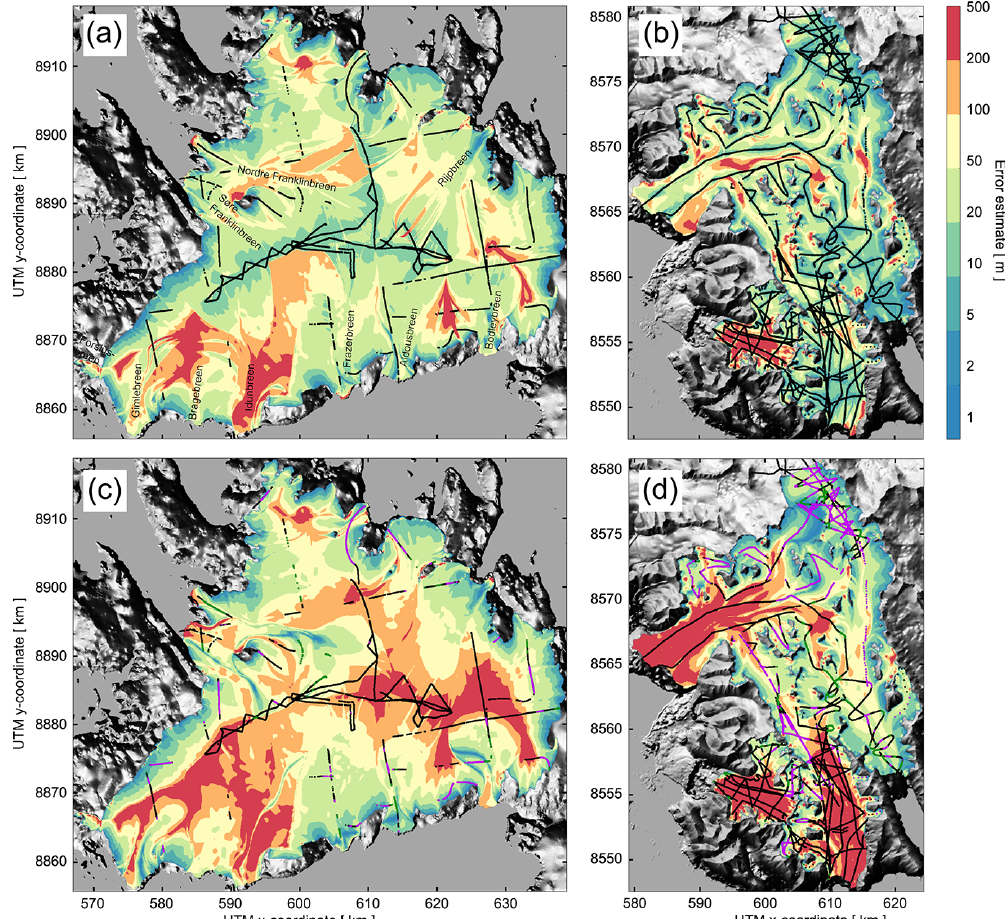
Figure 6. Error-estimate map based on the error propagation presented in Sect. (2.2.5) for VIC (a, c) , THPB and WSB (b, d) . Values are most elevated in the vicinity of unconstrained ice divides and ridges as well as in other stagnant areas. Error estimates are equal to the measurement uncertainty where observations were collected. Upper and lower panels reflect the amount of considered thickness measurements as in Fig. 4. Black dots indicate the measurement locations. For the withheld fraction of measurements, dots are coloured where the difference between observed and reconstructed thickness values exceeds the error bounds. For these outliers, green or purple colours indicate that observations are strongly over- or underestimated by the reconstruction, respectively. Background: grey-scale hill-shaded topography based on a NPI 50m DEM